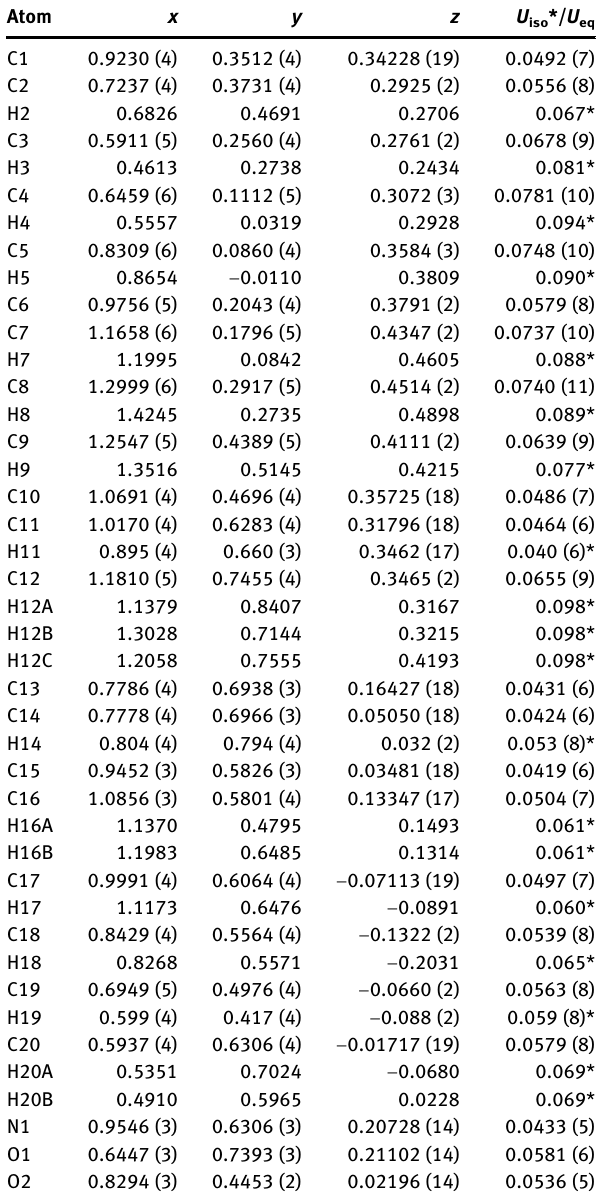
Table  : Fractional atomic coordinates and isotropic or equivalent isotropic displacement parameters (Å 